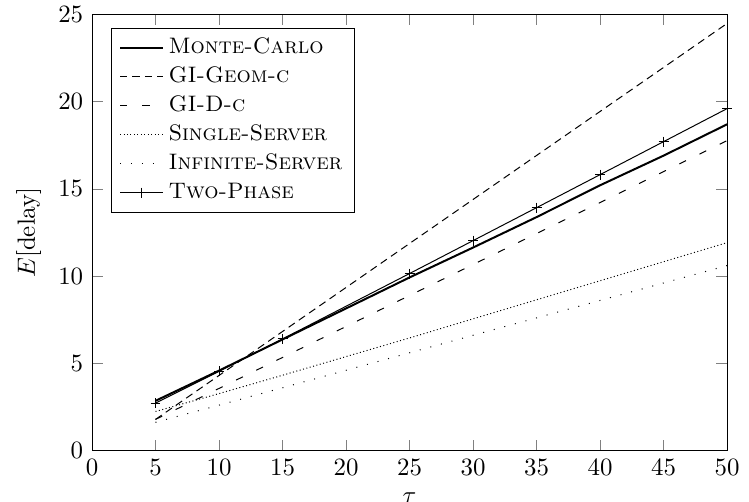
Figure 4. Mean customer delay versus mean service demand τ for a five-server system with Poisson arrivals, deterministic service demands of τ work units, and uniformly distributed service capacities between 0 and 10 work units (inclusive), with arrival rate λ scaled such that the load ρ = 0.9, as estimated by various